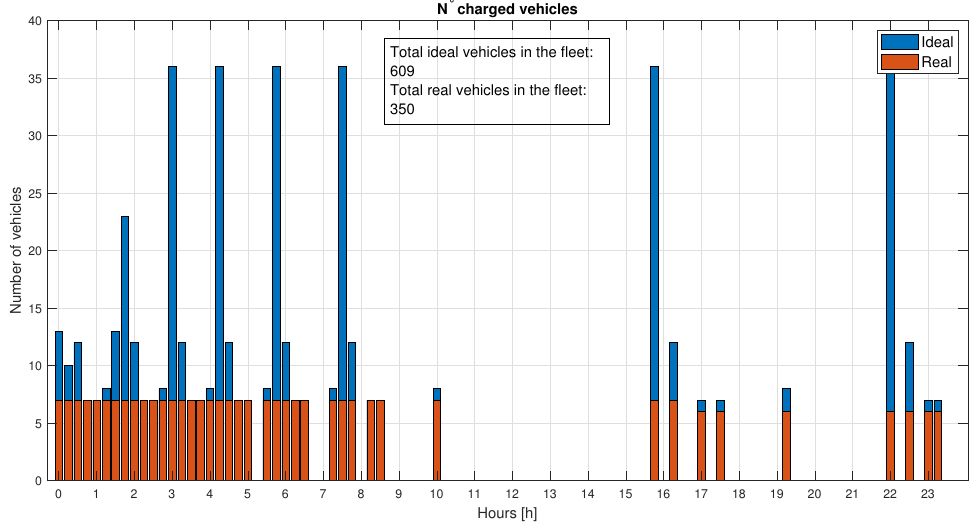
Figure 15. Real connection with PV and storage.